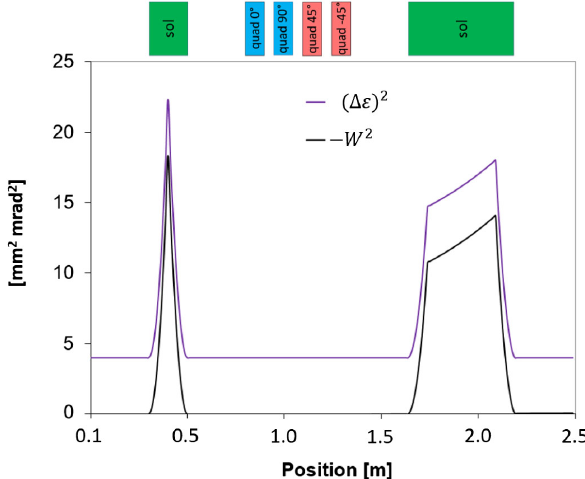
FIG. 6. Squared difference of eigenemittances (violet) and squared beam phase integral (black) as obtained from tracking